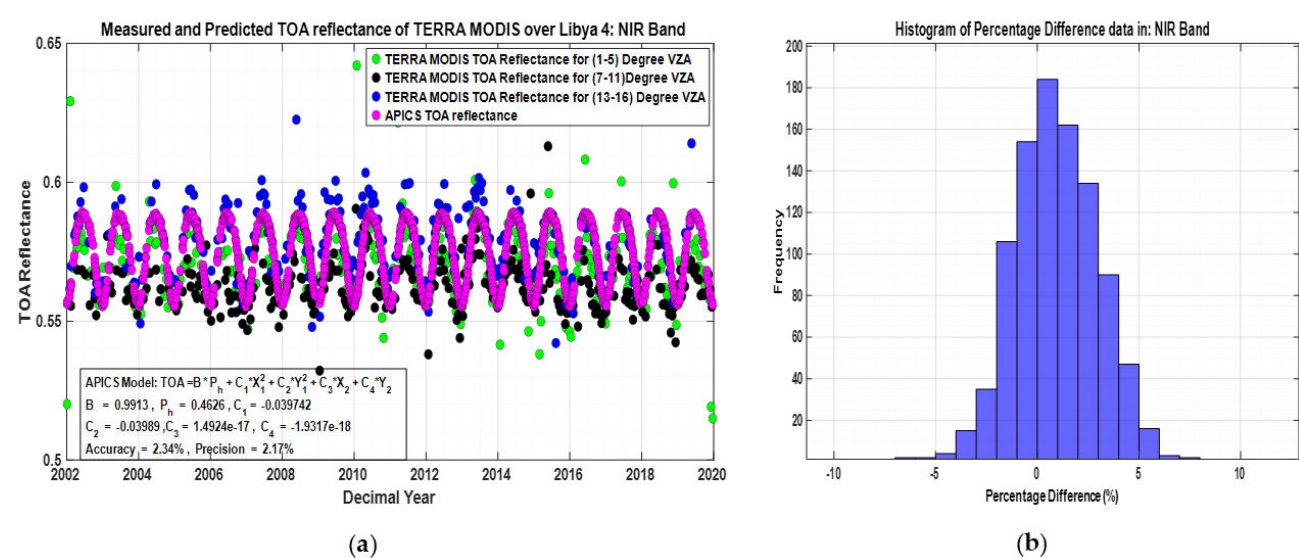
Figure 17. ( a ) Terra MODIS observation over Libya 4 (black, blue, green circle) and model prediction (magenta circle) in NIR band; ( b ) percentage difference analysis plots of the model in NIR band of Terra MODIS.